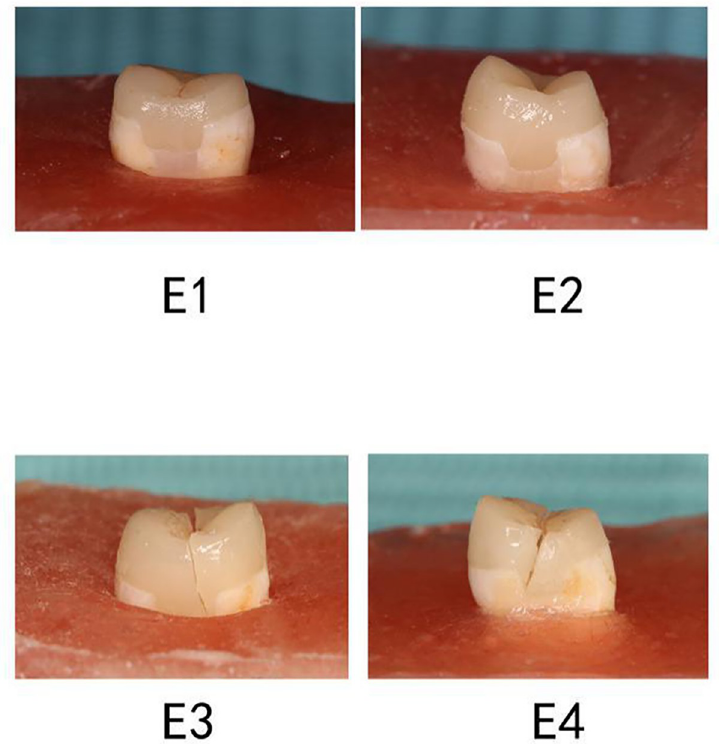
Fig 2. Images of fractures in different groups. Groups E1, E2 and E3, with proximal margins located in dentin/ cementum, subgingival. Group E4 (supragingival group), with proximal margins located in enamel above the CEJ, as the positive control. Group E1 was with bulk-fill Smart Dentin Replacement, and E2 with conventional resin composite. Group E3 was treated with a ceramic crown, as the negative control.